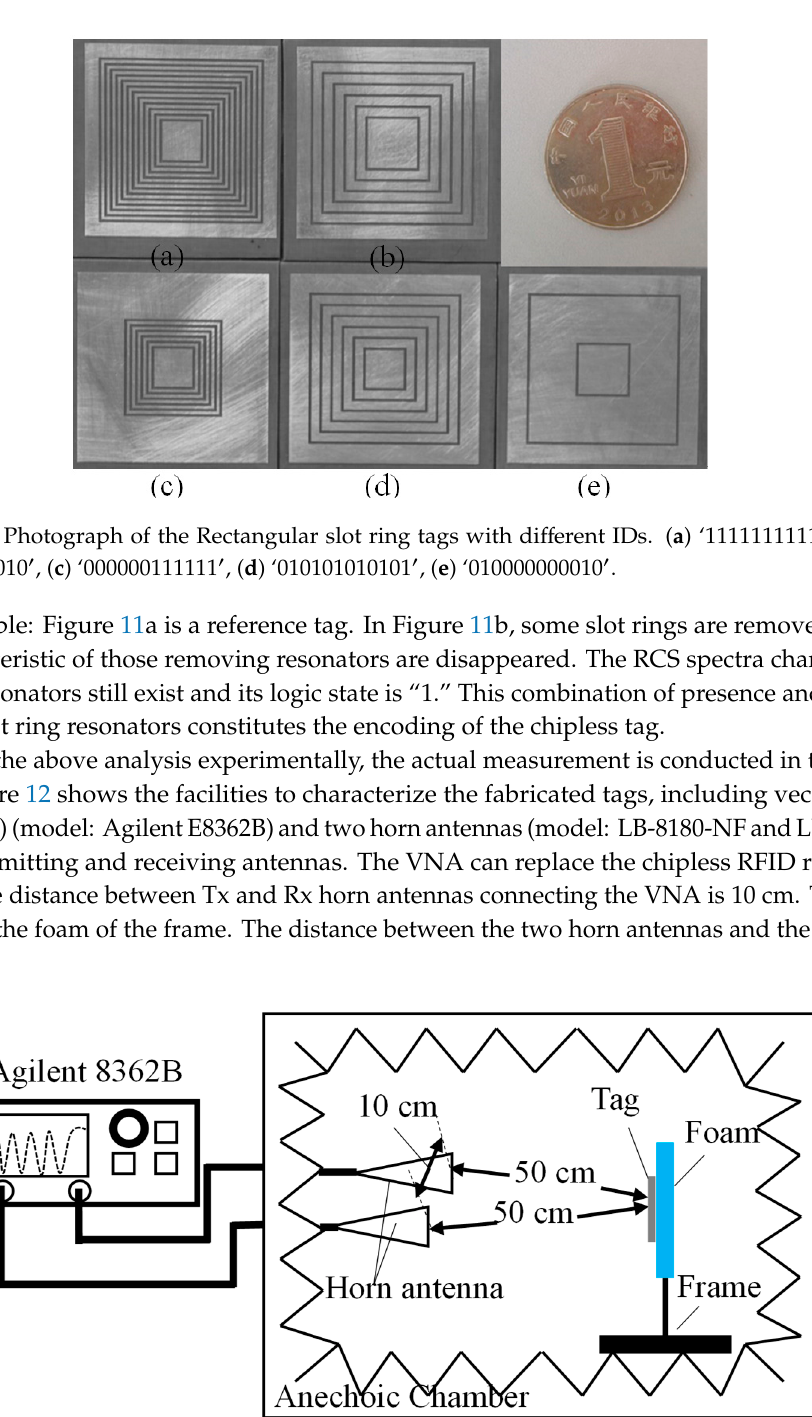
Figure 12. Block diagram of the measurement setup. Distance between two horn antennas is 10 cm and distance between horn antenna and tag is 50 cm.